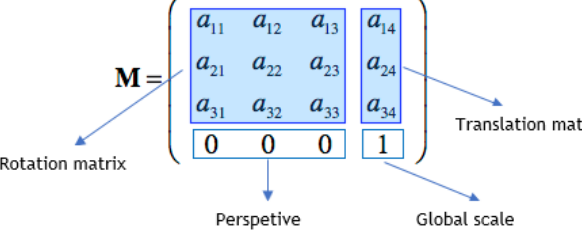
Figure 3. Representation of the homogeneous